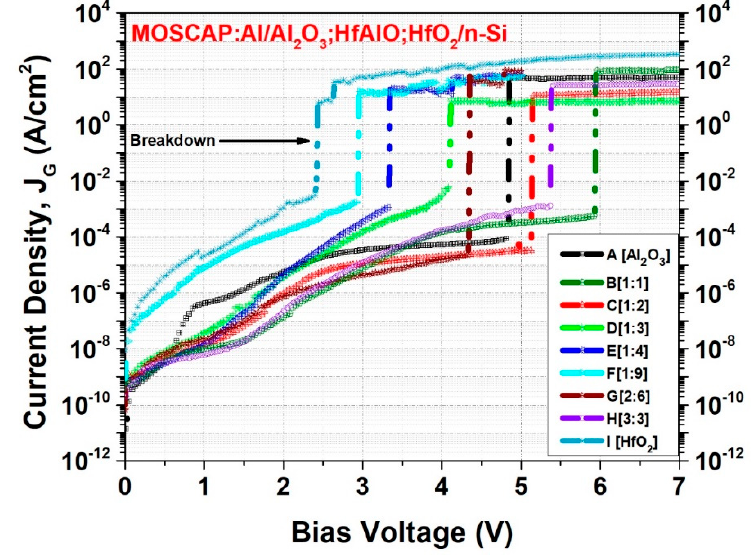
Figure 6. Leakage current density and breakdown voltage measurements under applied positive bias voltage for all the MOS capacitors.